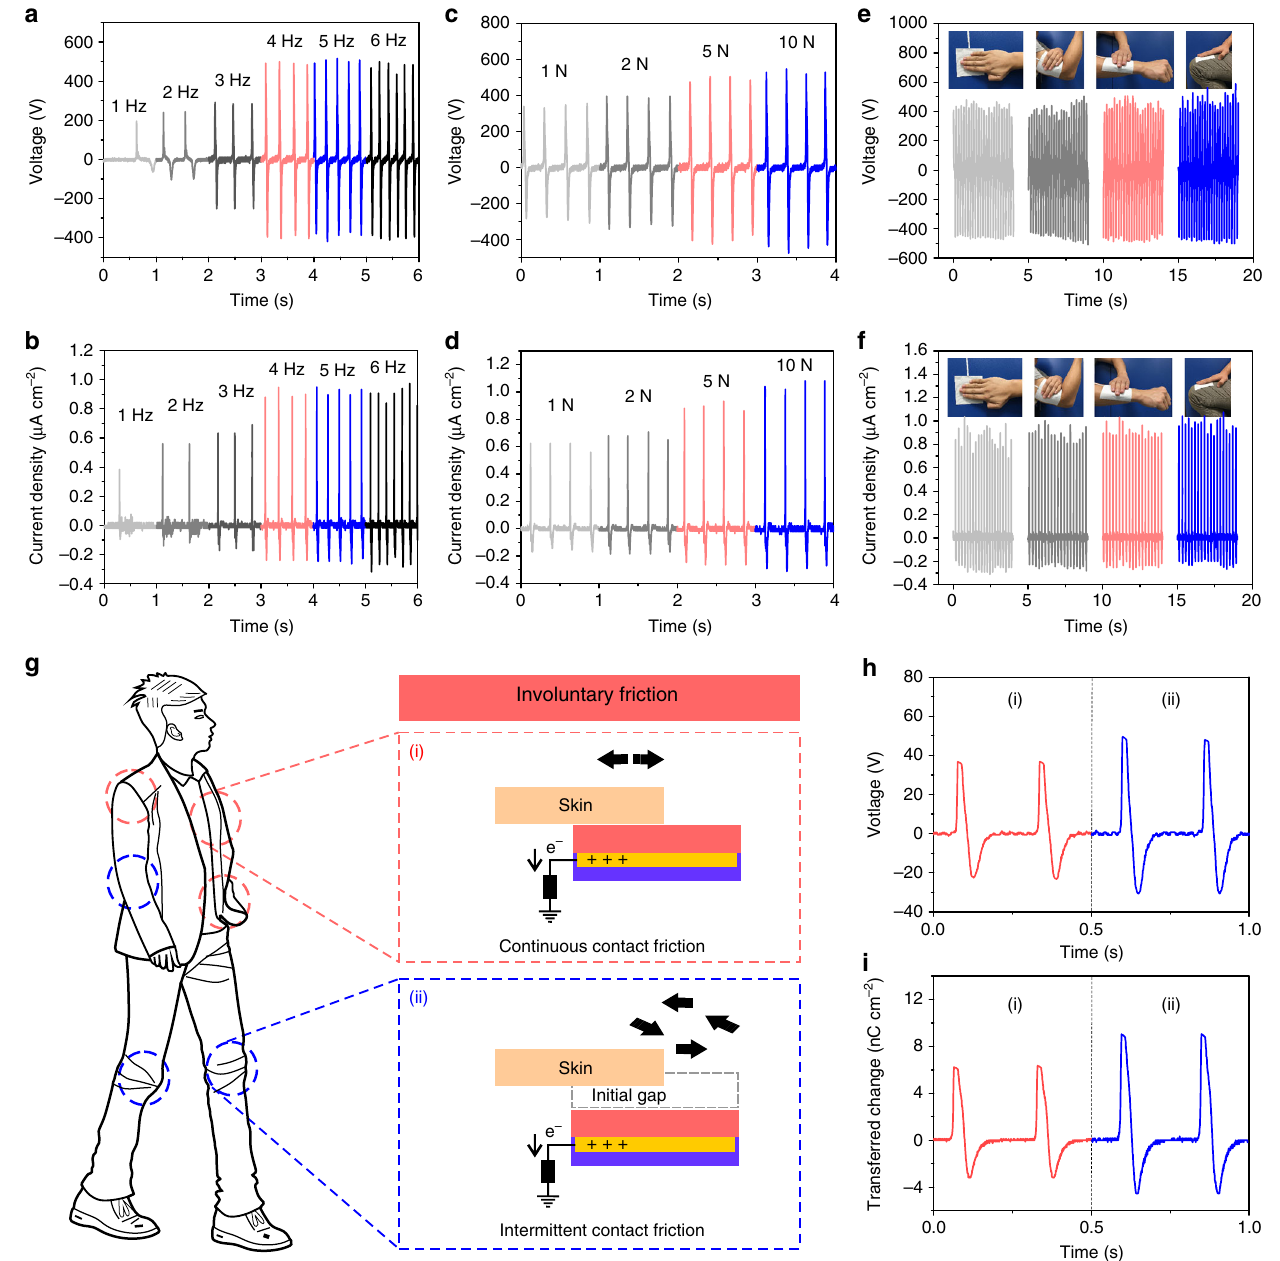
Fig. 3 Electrical outputs of textile triboelectric nanogenerator under voluntary and involuntary friction. a Output voltages and b current densities of textile triboelectric nanogenerator (textile-TENG) under 5 N touch with different frequency. c Output voltages and d current densities of textile-TENG under 4 Hz touch with different forces. e Output voltages and f current densities of textile-TENG mounted on different body regions. g Schematically illustration of the possible involuntary friction of textile-TENG on different regions of human body. (i) Continuous contact friction (red circles), (ii) Intermittent contact friction (blue circles). The human silhouette image was created by Jiaqing Xiong for use in this fi gure. h , i Output voltages and transferred charge densities of textile-TENG in the case of involuntary friction with human body with continuous (red curve, i) or intermittent contact friction (blue curve,